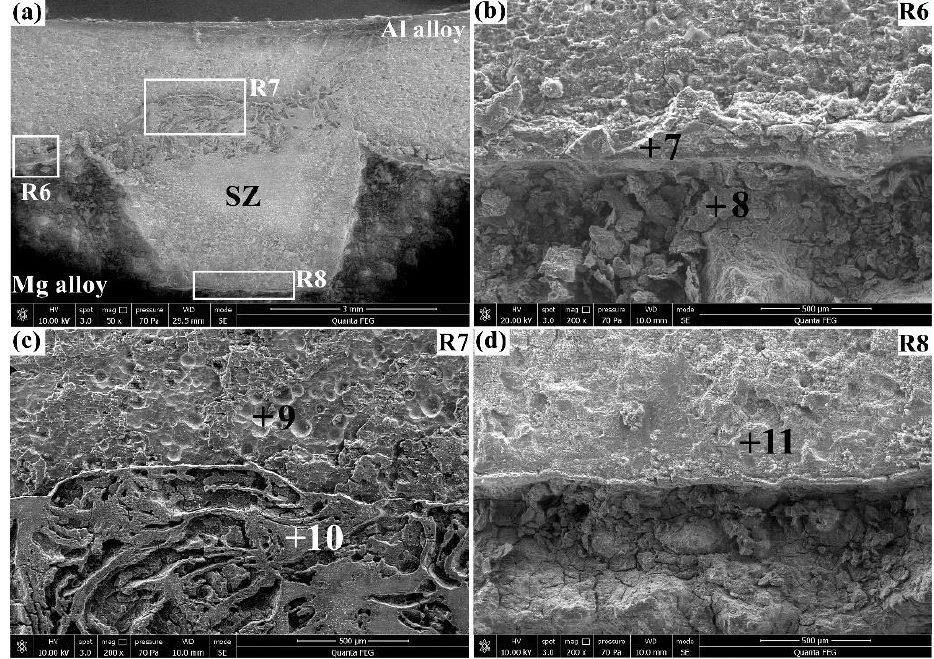
Figure 8. Corrosion morphologies of the Al/Mg joint in the 3.5% NaCl solution for 4 h: ( a ) overview and ( b – d ) magnified views of the R6, R7, and R8, respectively. Table 5. Elemental compositions (in wt.%) of points 7–11 in Figure 8b–d. Points Al Mg Others